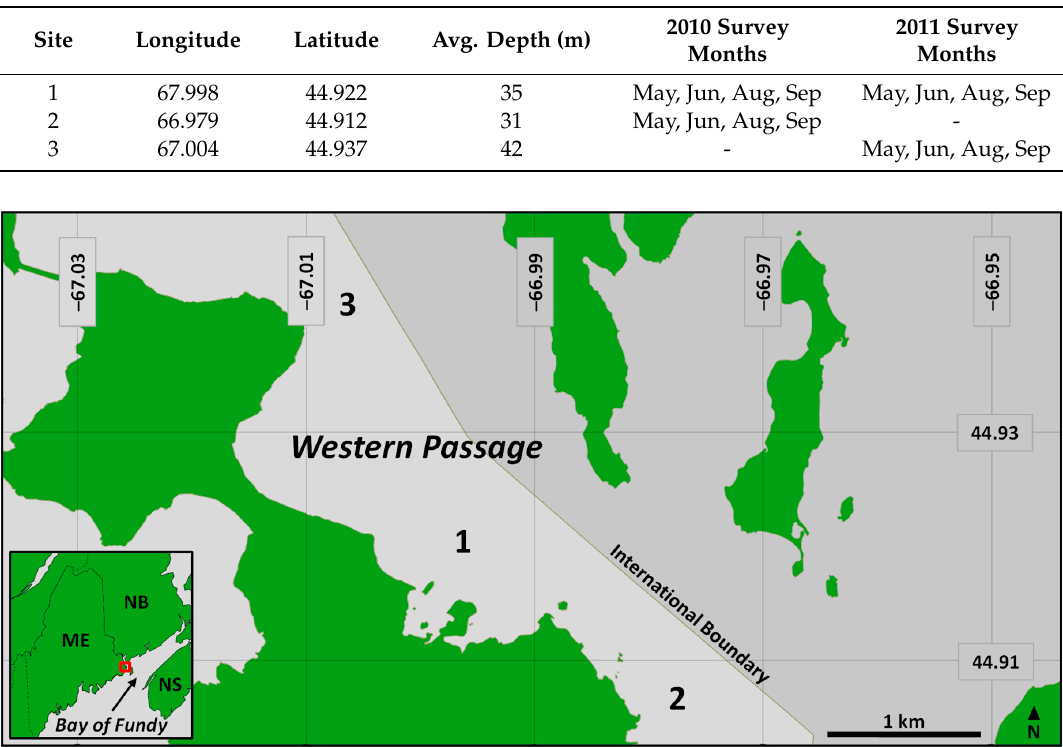
Figure 1. Map of the hydroacoustic sampling sites in Western Passage. Inset map shows Maine, USA and the red square represents the large-scale map. Site 2 was a tidal turbine project site and sites 1 and 3 were control sites for fish biomass and vertical distribution comparisons. The town of Eastport, Maine is just south of site 2. Dark gray indicates Canada and light gray indicates the US. Coordinate grid is latitude and longitude in decimal degrees. Table 1. Characteristics of each sampling site and months of 24-h hydroacoustic surveys. Depth variation is due to tidal stage, bathymetry, and vessel movement.